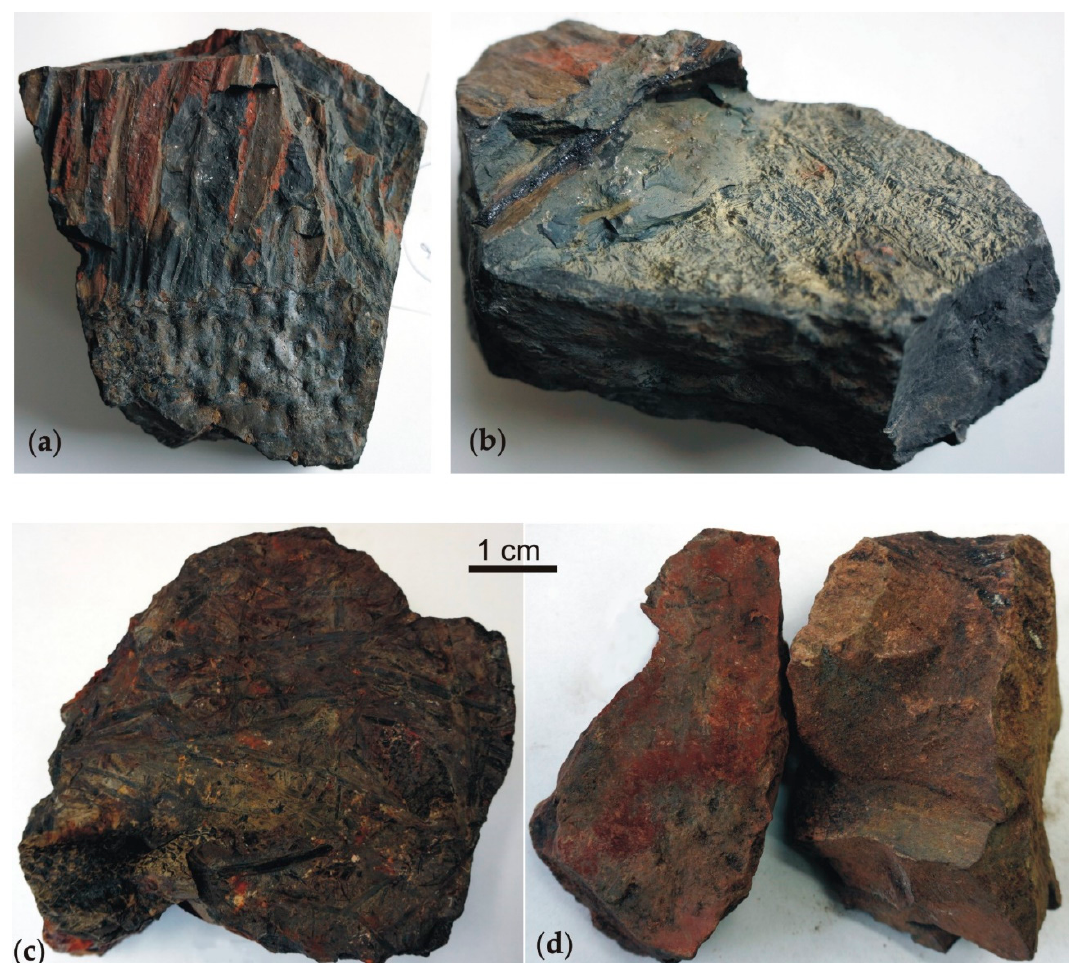
Figure 4. Samples collected from the vicinity of the disappearing coal seams located in the northern part, ( a ) sample N1 and ( b ) sample N4, and southern part, ( c ) sample S2 and ( d ) sample S5, of the Jas-Mos mining area, a part of the Jastrz˛ebie-Bzie Coal Mine.